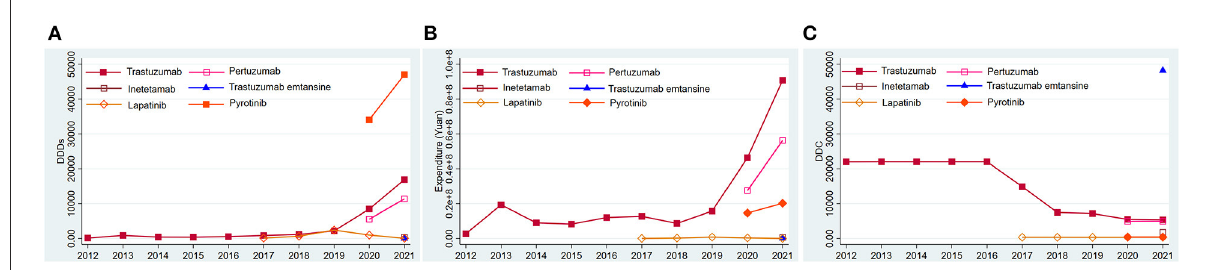
FIGURE3 Consumption of six types of anti-HER2 drugs in Nanjing from 2012 to 2021. (A) DDDs of six types of anti-HER2 drugs; (B) Expenditure of six types of anti-HER2 drugs; (C) DDC of six types of anti-HER2 drugs. DDDs, defined daily doses; DDC, defined daily cost.